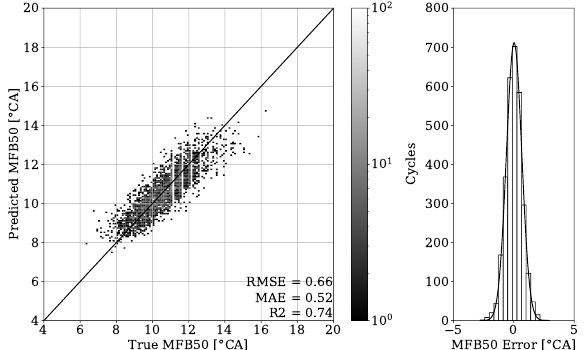
Figure 24. MFB50 regression of test set from engine 2.